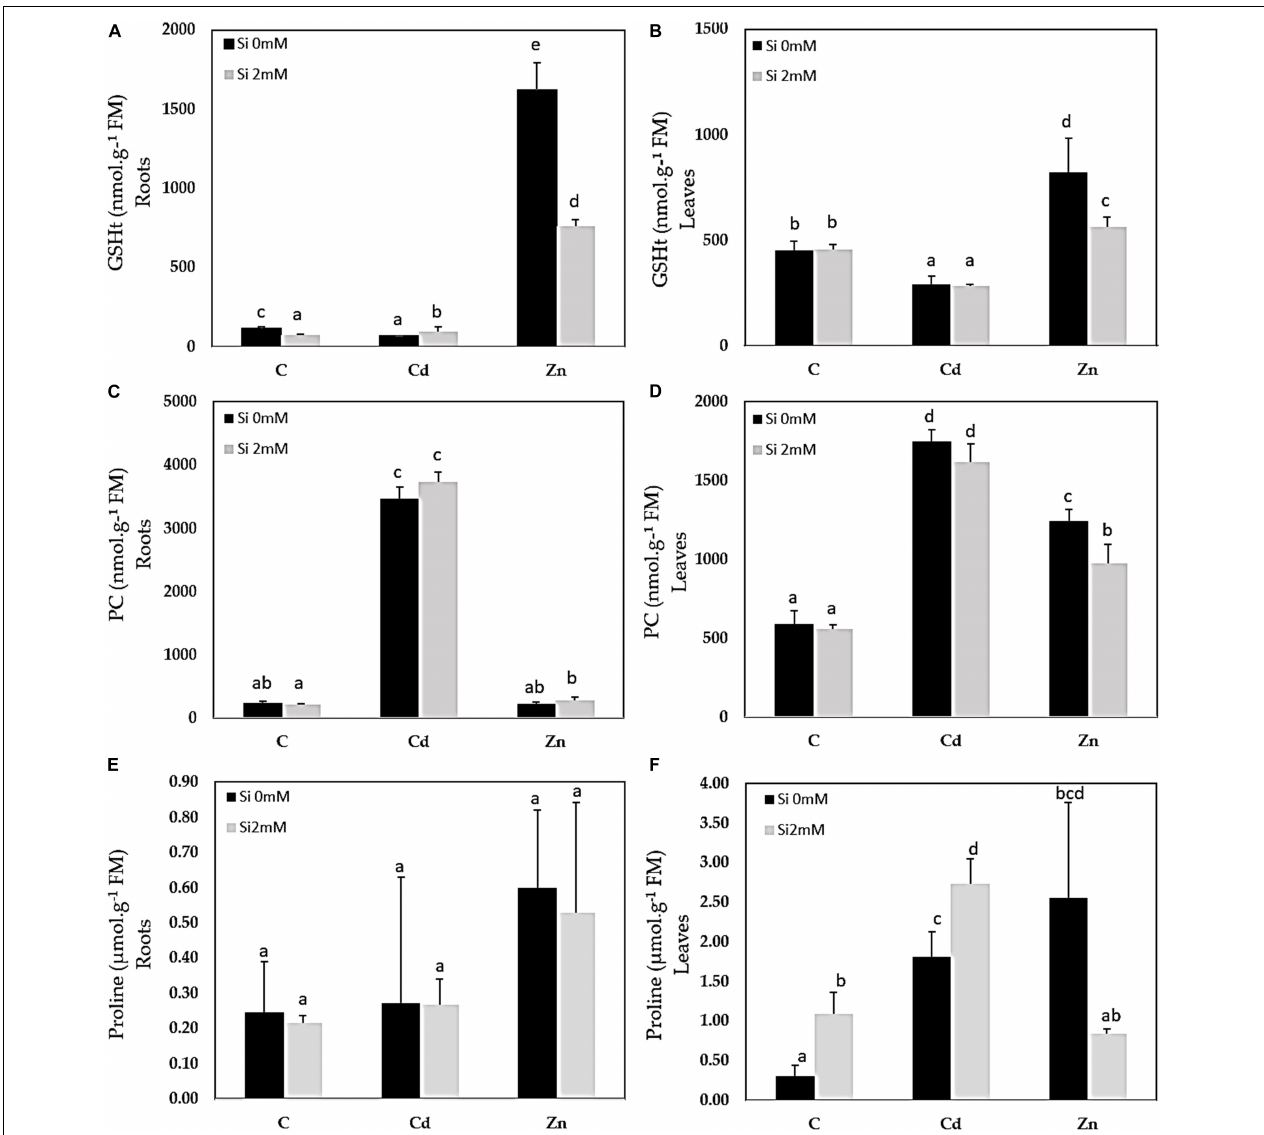
FIGURE 2 | Glutathione (GSHt), phytochelatin (PC), and proline contents in roots (A,C,E) and leaves (B,D,F) of C. sativa (cv. Santhica 27). Plants were exposed for 1 week to Cd (20 µ M) or Zn (100 µ M) in the presence or absence of Si (2 mM) (C: control plants not exposed to HM). The different letters indicate that the values are significantly different from each other ( p < 0.05; Tukey’s HSD all-pairwise comparisons). were found to be less abundant in comparison to